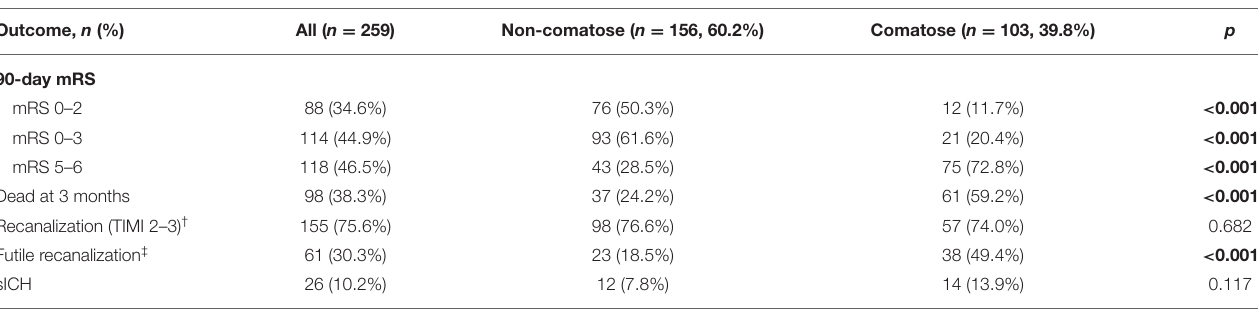
TABLE 3 | Outcome measures between comatose vs. non-comatose patients. Outcome, n (%) All ( n = 259) Non-comatose ( n = 156, 60.2%) Comatose ( n = 103,